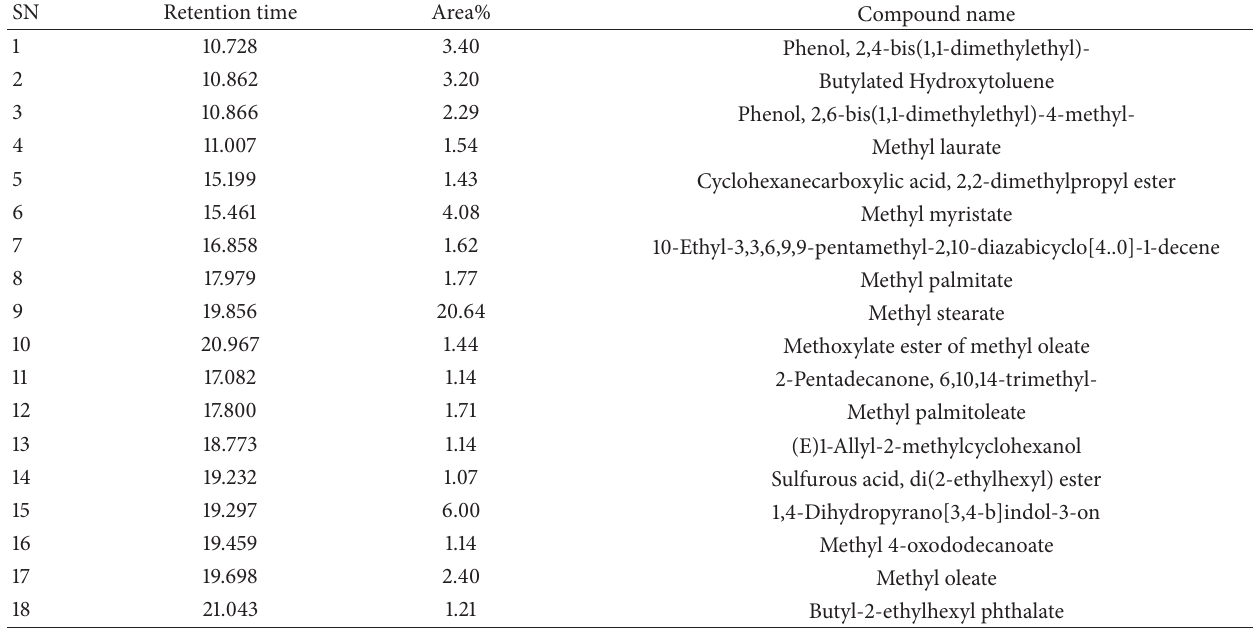
Table 4: Fatty acid profile of lipid band no. 1 of Hexane : EtOH